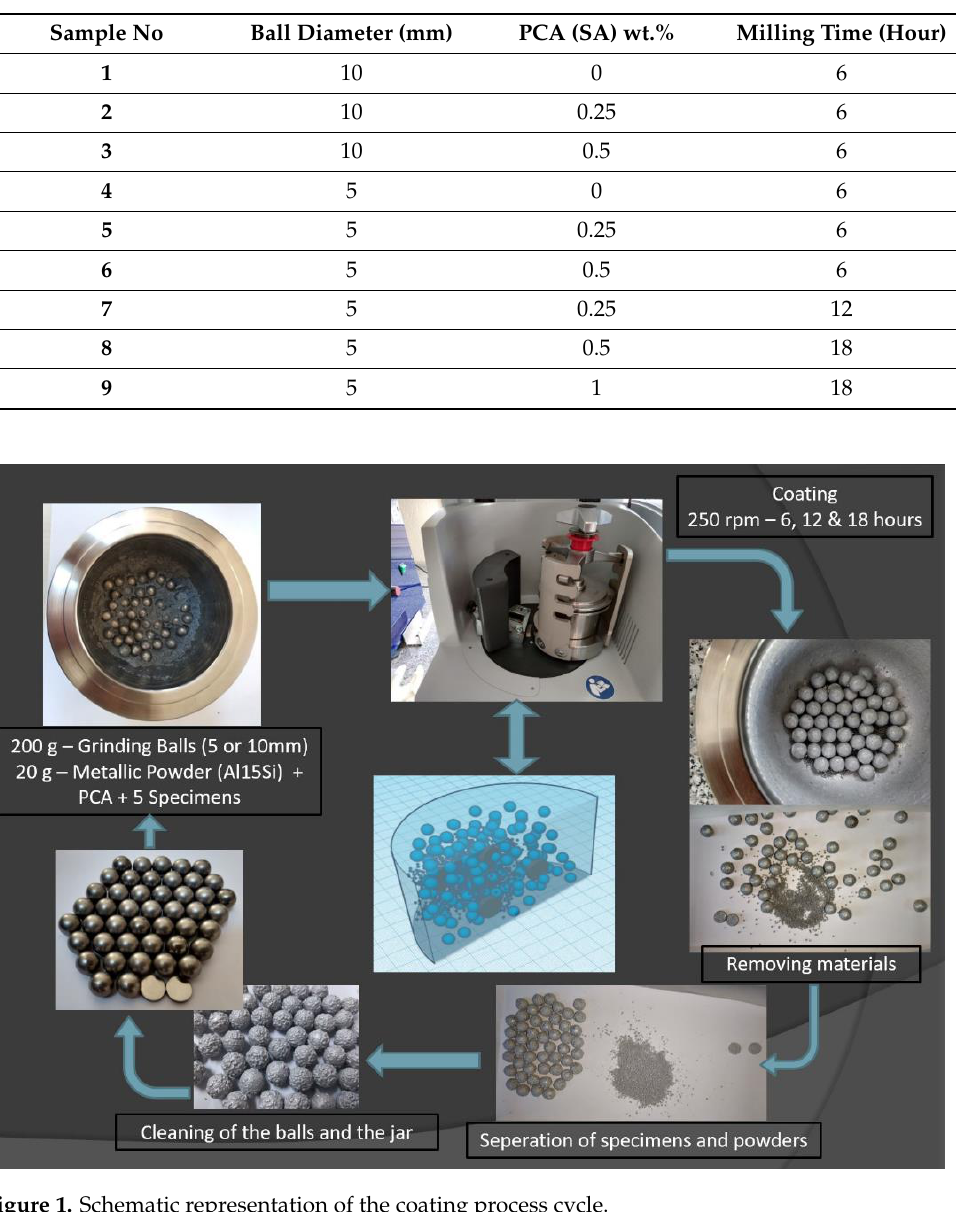
Table 2. Specifications of mechanically alloyed samples.